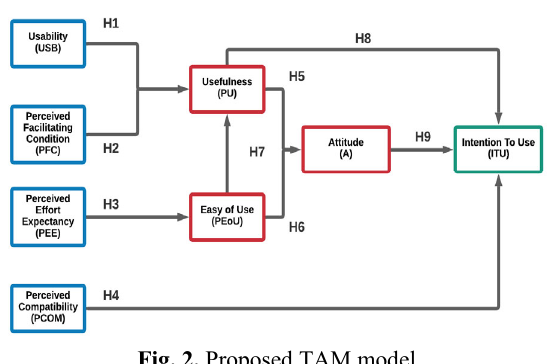
Fig. 2. Proposed TAM